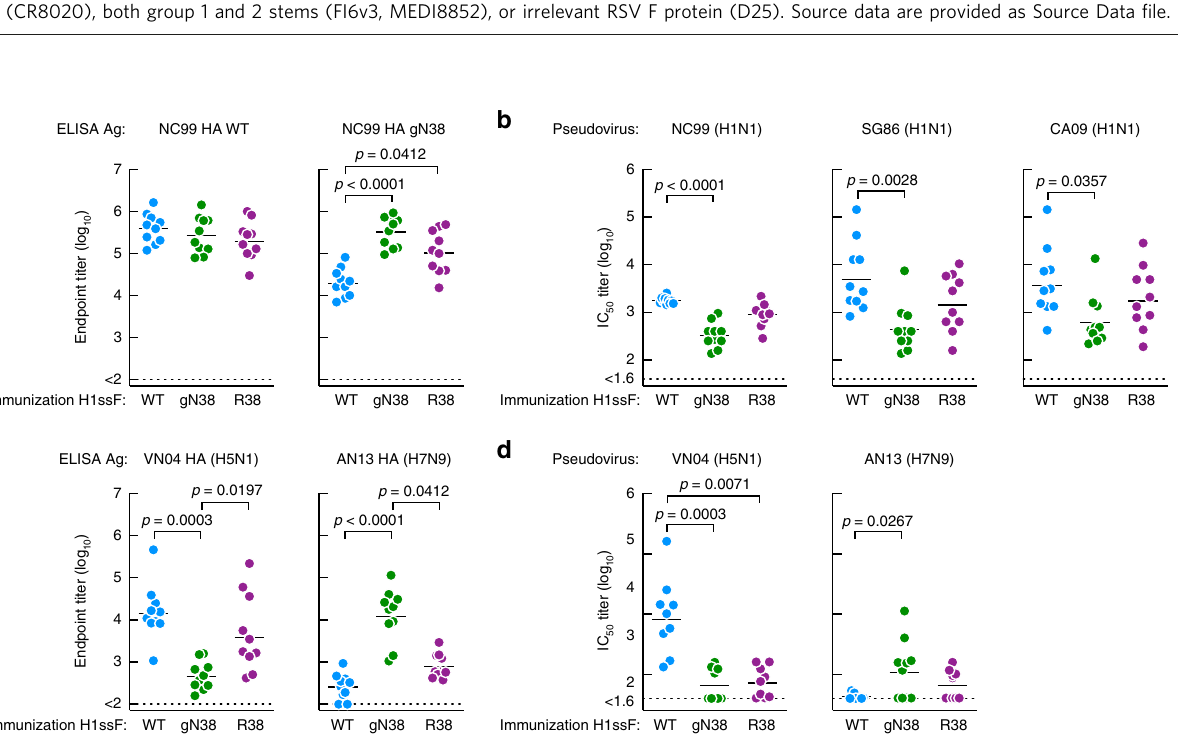
Fig. 1 Design and characterization of group 1 H1 stem nanoparticle variants. a Comparison of N -linked glycosylation pattern of group 1 and group 2 HA stem. Surface renderings of HA trimer for a representative group 1 HA (A/Solomon Islands/06 (H1N1), PDB: 3SM5, left) and representative group 2 HA (A/Finland/486/04 (H3N2), PDB: 2YP5, right). One monomer is colored in blue for visibility. The terminal N -acetylglucosamine (GlcNAc) moiety for each glycan is modeled in green and residue positions are labeled according to the H3 numbering. Yellow areas designate the approximate location of the CR6261 epitope on each HA. b Amino acid sequence alignment of N-terminal portion of HA1 of H1 (A/New Caledonia/20/99), H3 (A/Finland/486/04) and designed variants gN38 and R38. Dots and dashes indicate residues identical to H1 and gaps, respectively. c Cryo-electron microscopy structures of H1 stem nanoparticle (H1ssF WT) and its variants H1ssF gN38 and H1ssF R38. Nanoparticles are depicted along the 2-fold symmetry axis. Side views of HA stem trimeric spikes are shown below each nanoparticle. The maps were low-pass fi ltered to a resolution of 7 Å for comparison. Scale bar indicates 5 nm. d Antigenicity of H1 stem nanoparticle variants. ELISA binding curves are shown for mAbs speci fi c to group 1 stem (CR6261, 02-1H01 and C179), group 2 stem (CR8020), both group 1 and 2 stems (FI6v3, MEDI8852), or irrelevant RSV F protein (D25). Source data are provided as Source Data fi le.